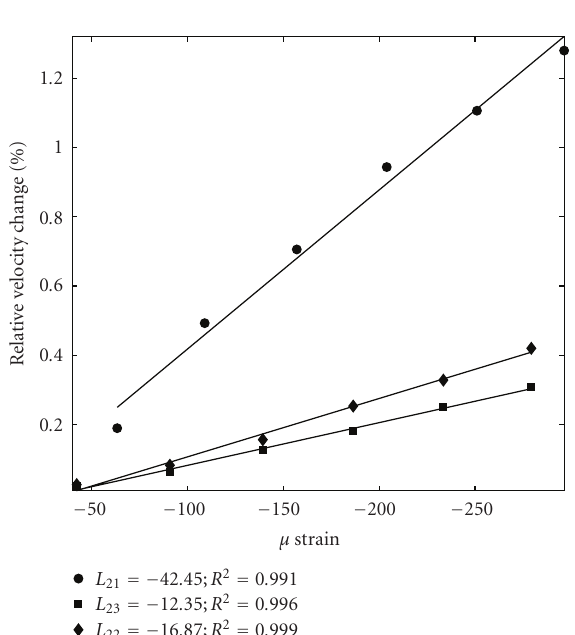
Figure 3: Relative velocity variations as a function of